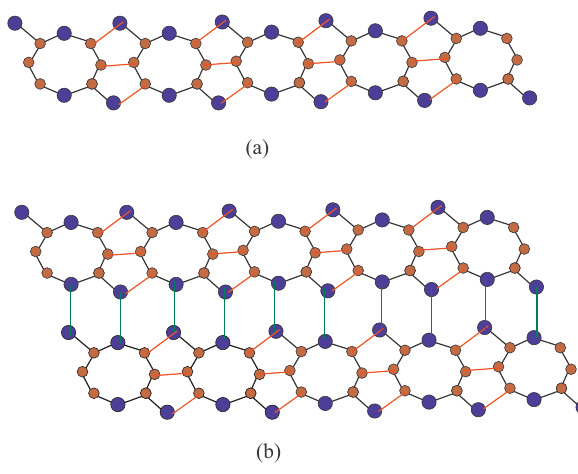
Figure 2: ( a ) 2D structure of Si C 2 3 - III [ 5,1 ] , ( b ) 2D structure of Si C 2 3 - III [ 5,2 ] .